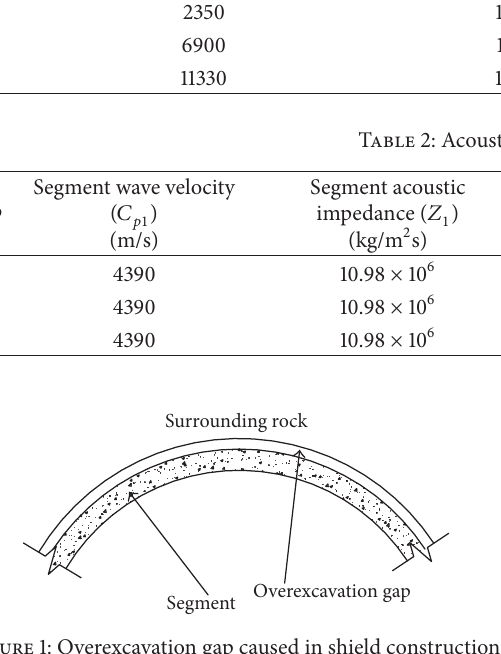
Figure 1: Overexcavation gap caused in shield